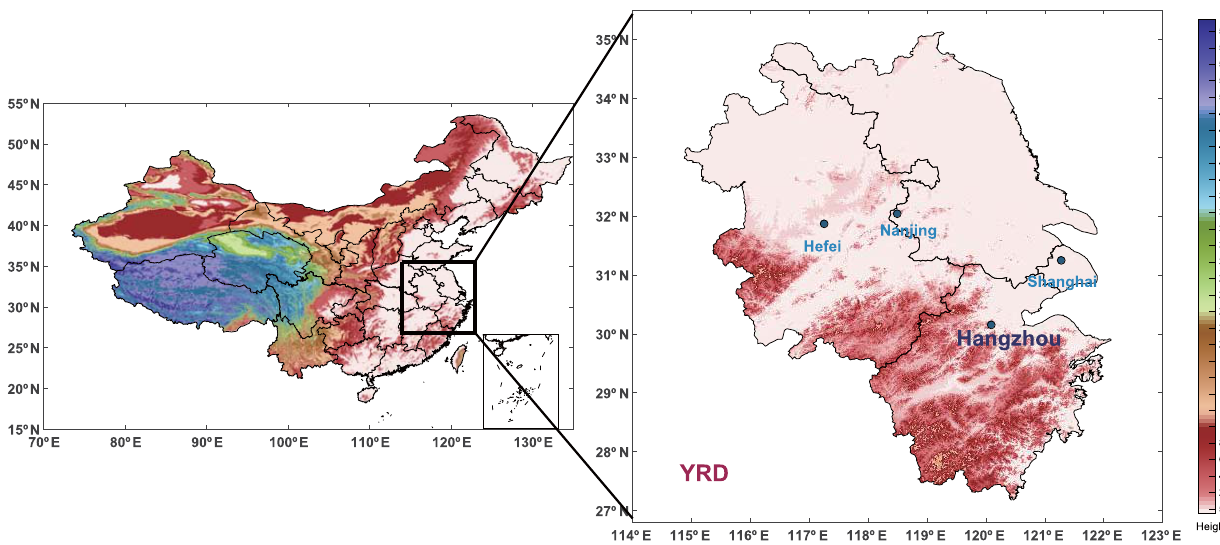
Figure 1. Terrain elevation and location of the Yangtze River Delta region in China.